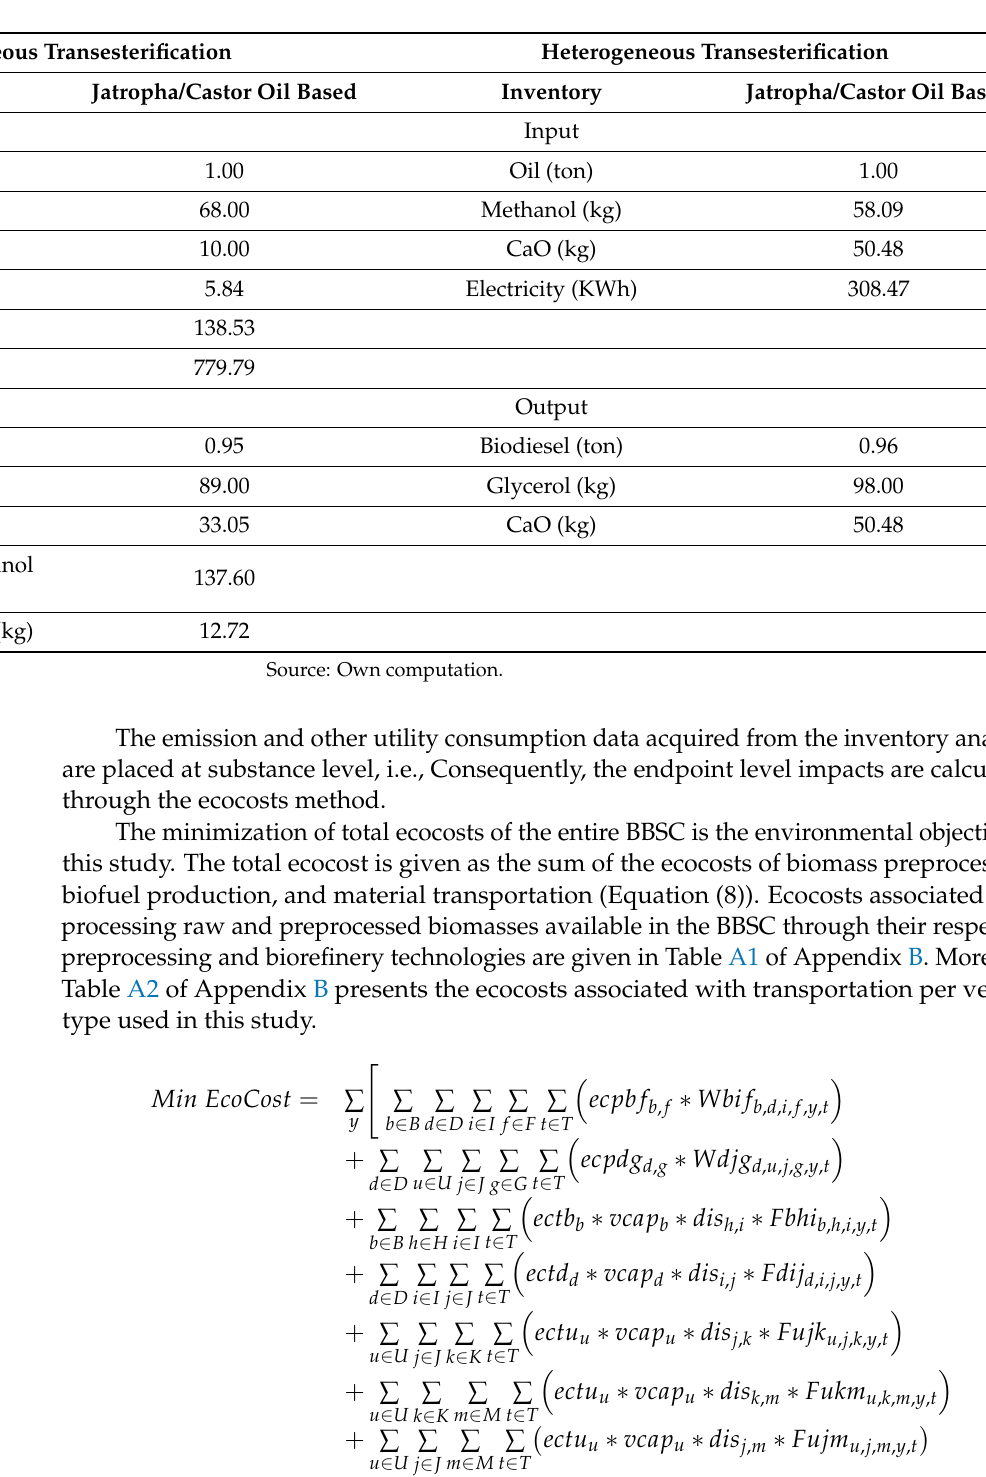
Table 4. Material and energy inputs and outputs in homogeneous and heterogeneous transesterification of jatropha/castor